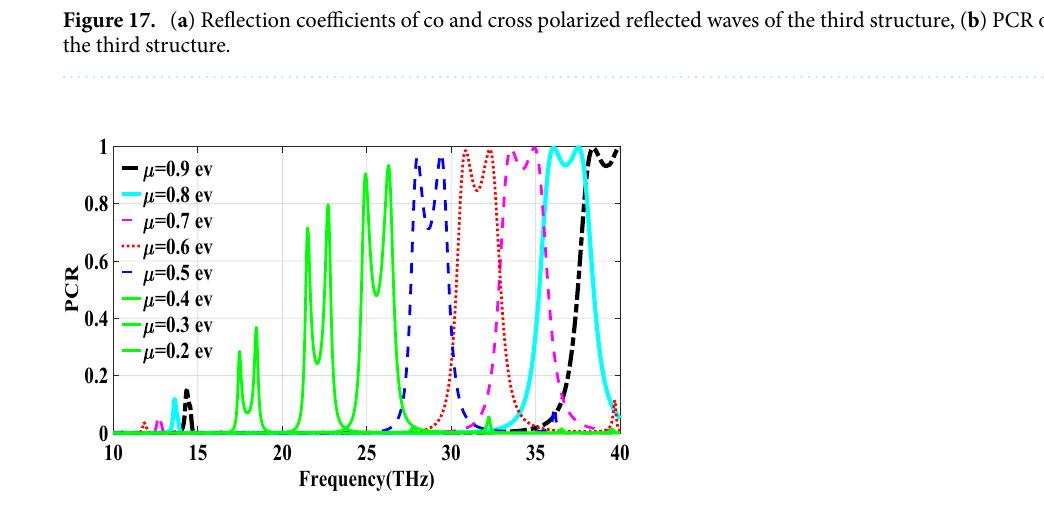
Figure 18. PCR of the third structure for different chemical potentials of